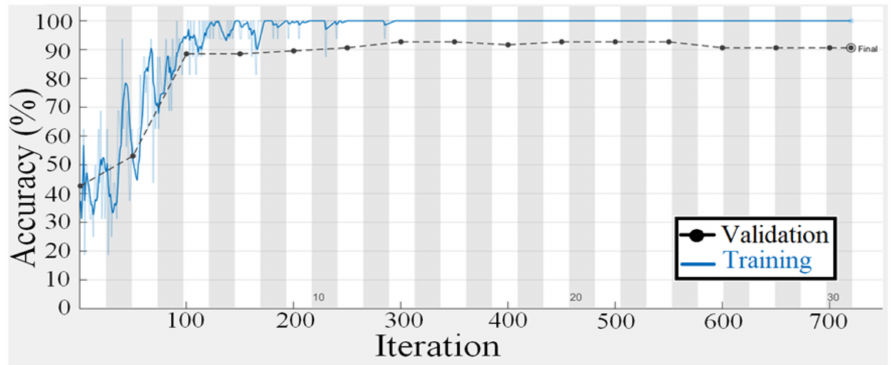
Figure 11. Training and validation accuracy plot of the gaze detection